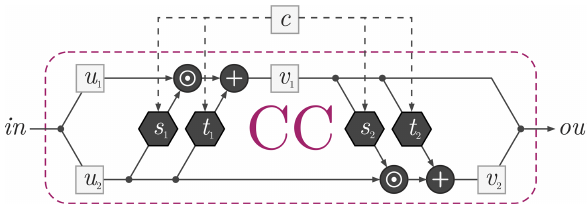
Figure 3. The conditional coupling blocks (CCs) with their embed- ded sub-network s 1 , t 1 , s 2 , and t 2 . This CC architecture can easily be inverted (Ardizzone et al.,